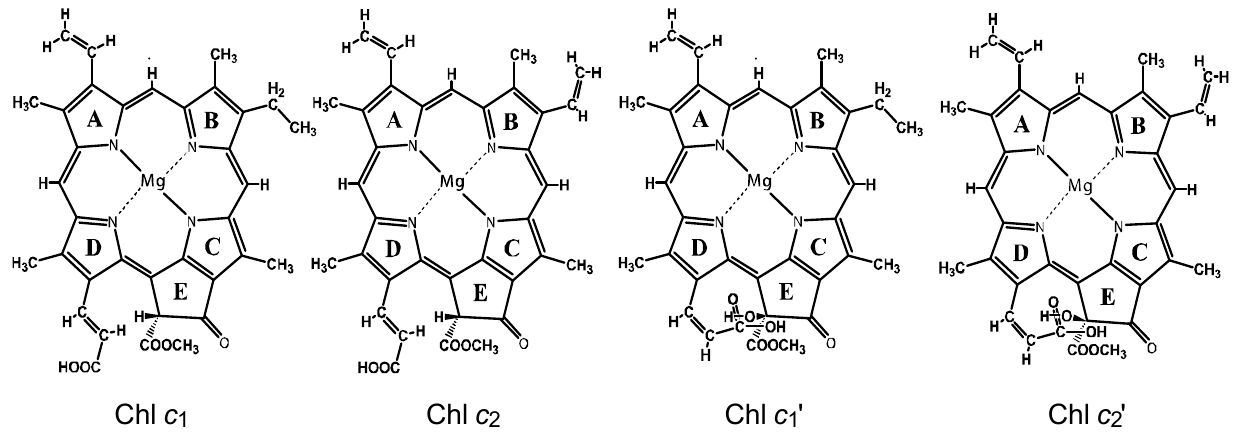
Figure 20. Chemical structures of Chl c with permission of MDPI Publishing).